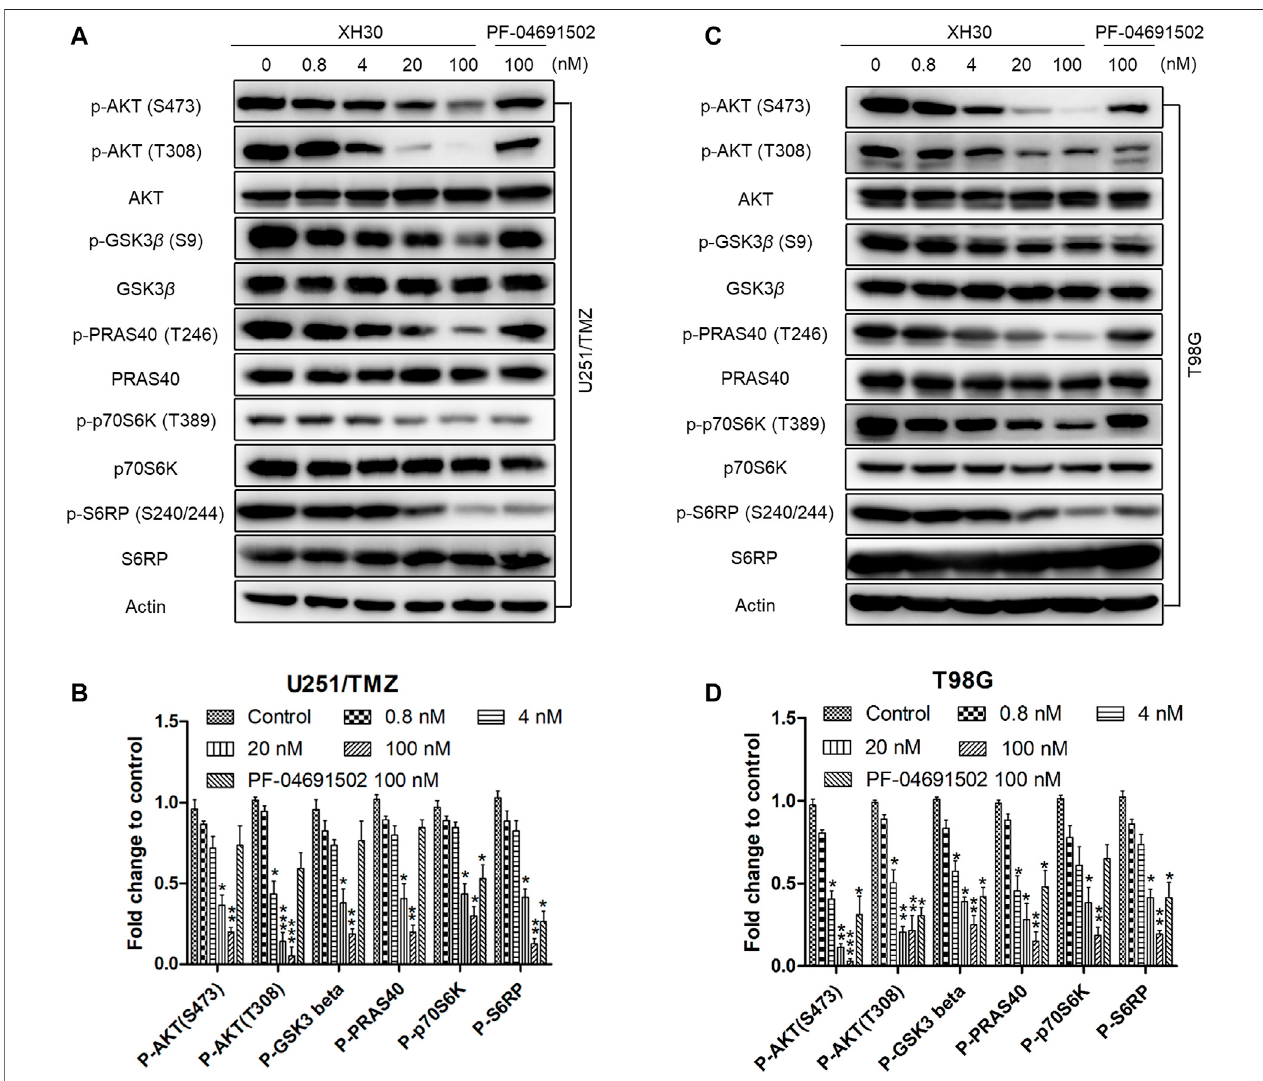
FIGURE 2 | The PI3K inhibitor XH30 suppressed the PI3K signaling pathway in TMZ-resistant GBM cells. (A) XH30 dose-dependently inhibited PI3K pathway signaling in TMZ-resistant U251/TMZ cells. The cells were incubated with XH30 at indicated concentrations (0.8, 4, 20, and 100 nmol/L) or PF-04691502 (100 nmol/L) asacontrolfor3 h.Theexperimentwasrepeatedthreetimes. (B) Relativeexpressionlevelsofthemajorproteinsin (A) .Dataarepresentedasmeans ± SD, n (cid:1) 3. t -test, * p < 0.05, ** p < 0.01,and *** p < 0.001compared withcontrol. (C) XH30dose-dependently inhibited PI3Kpathway signaling inTMZ-resistantT98Gcells. Thecells were incubated with XH30 at indicated concentrations (0.8, 4, 20, and 100 nmol/L) or PF-04691502 (100 nmol/L) as a control for 3 h. The experiment was repeated threetimes. (D) Relativeexpressionlevelsofmajorproteinsin (C) .Dataarepresentedasmeans ± SD, n (cid:1) 3. t -test,* p < 0.05,** p < 0.01,and*** p < 0.001,comparedwith